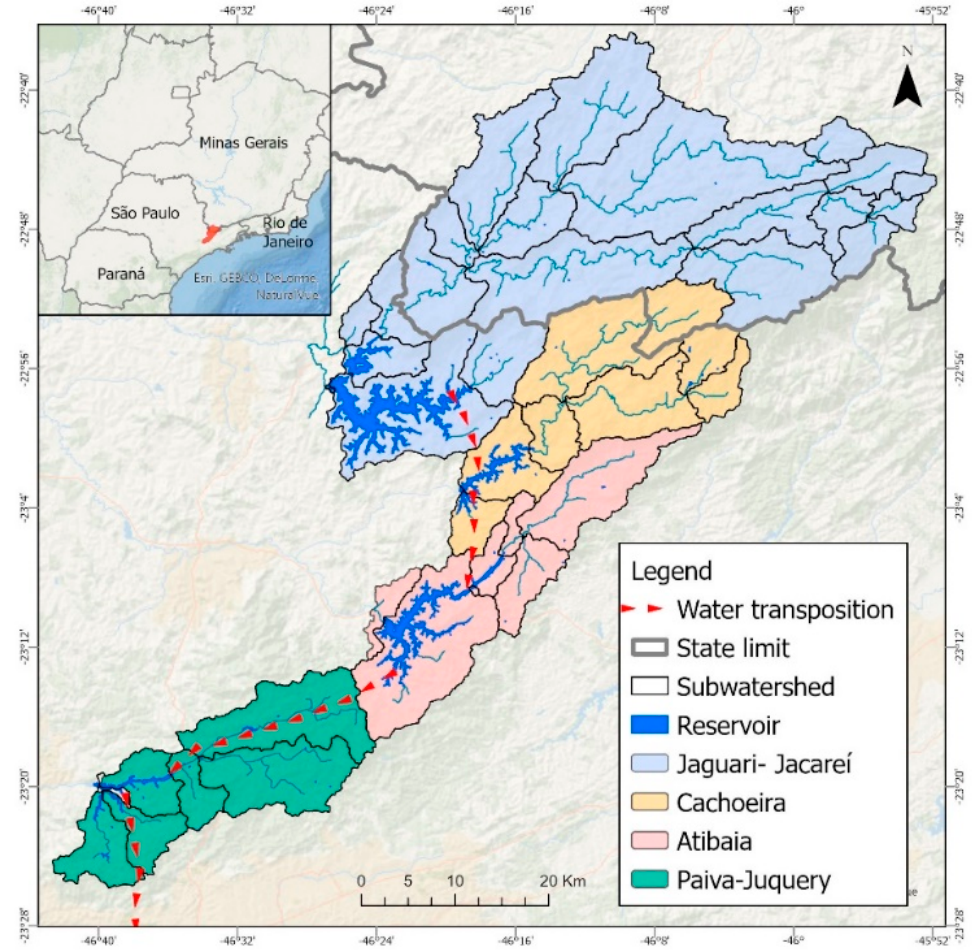
Figure 1. Geographic scope of the studied system showing the subwatersheds and reservoirs of the Cantareira system.